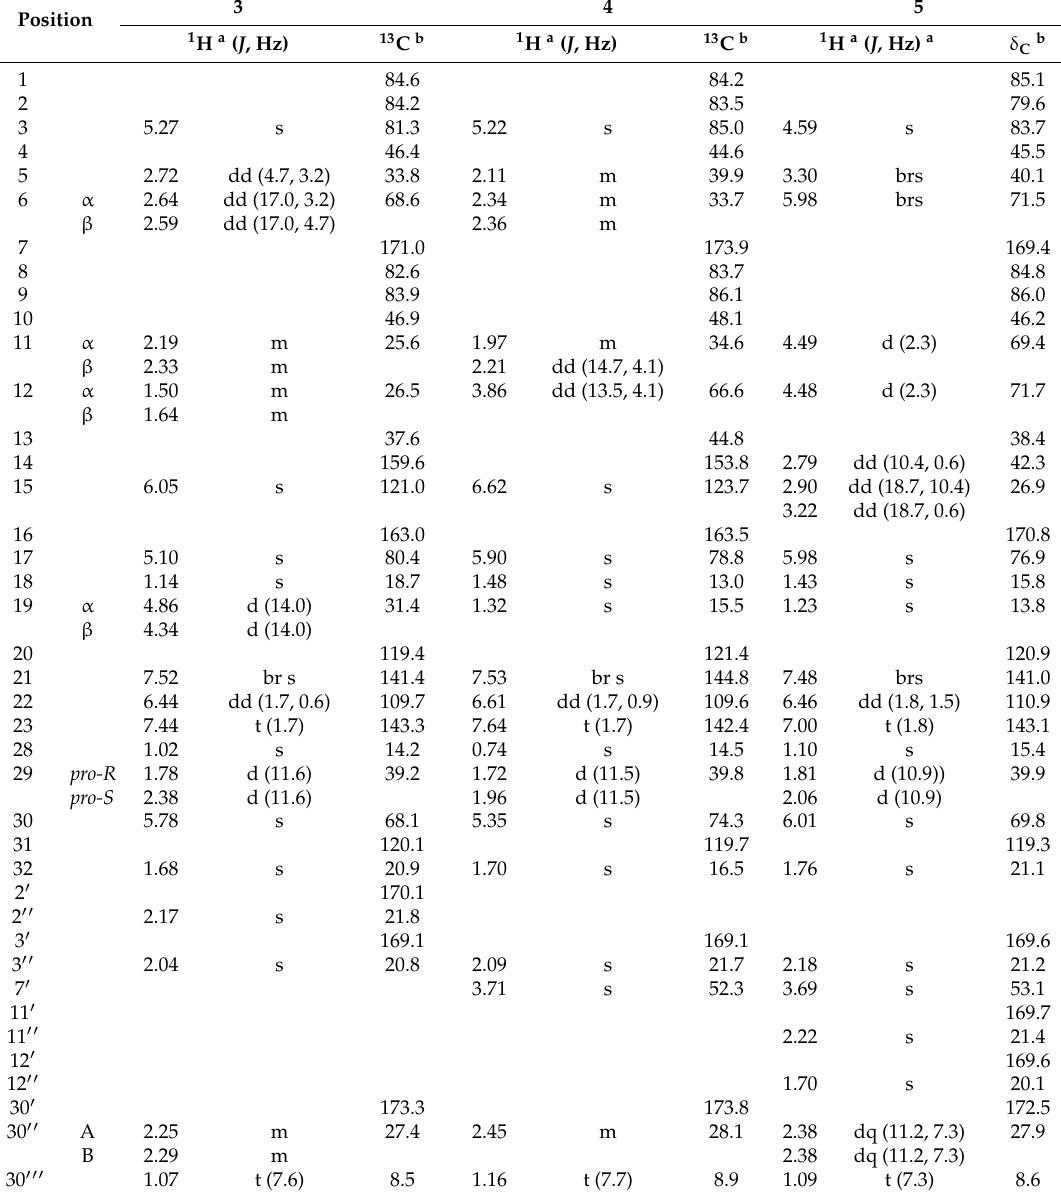
Table 2. 1 H- (600 MHz) and 13 C- (150 MHz) NMR spectroscopic data of compounds 3 – 5.